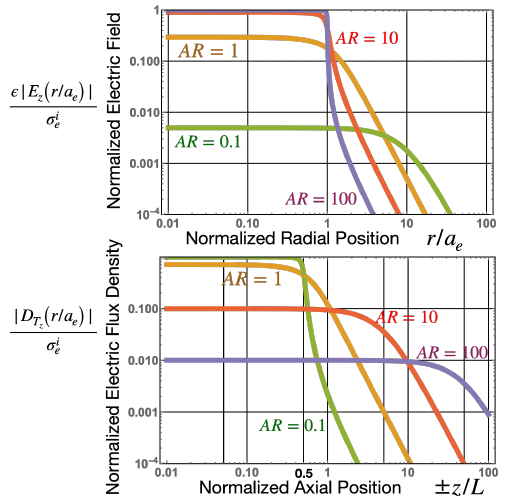
Figure 5. ( Above ): Normalized z component of the electric field, E z , versus normalized radial distance, at z = 0, from the centre of the electric dipole for various aspect ratios. Note, for the infinite dipole ( AR → 0), that the electric field is zero for all r . ( Below ): Normalized z component of the electric flux density, D T , versus normalized axial distance, at r = 0, from the midpoint of the electric z dipole for various aspect ratios. Note, for the infinitely wide dipole ( AR → ∞ ), D T Note the tangential E z field across the radial boundary of the dipole, at r the normal D T field is continuous across the axial boundary at z z